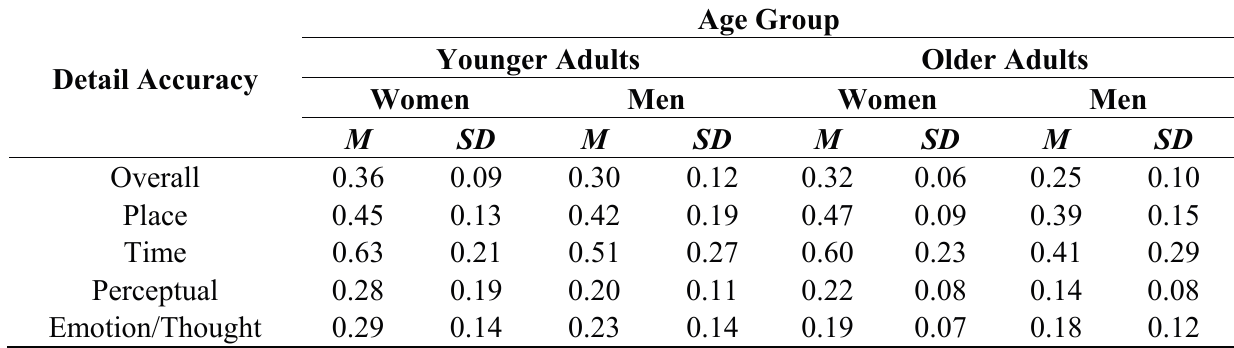
Table 4. Overall and category accuracy of detail recall by age and gender.